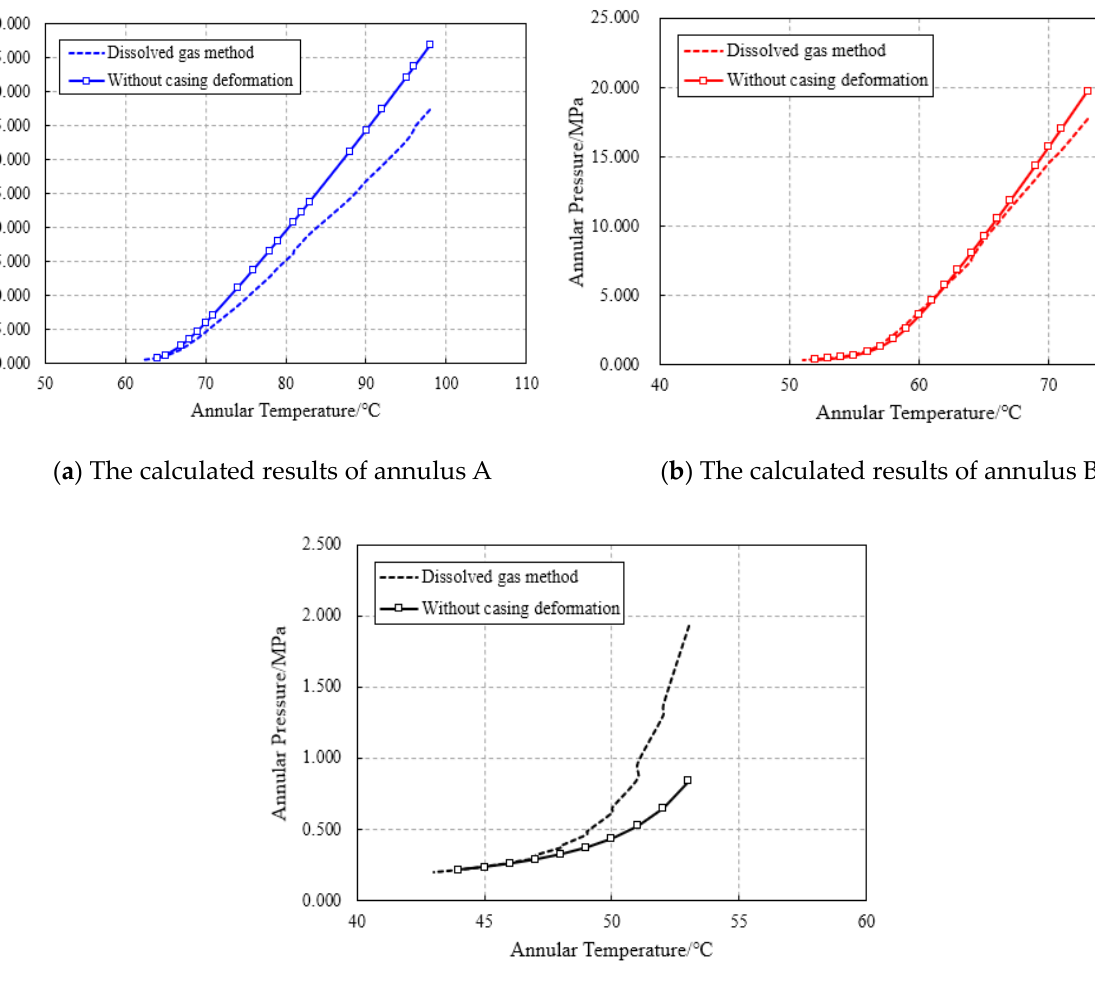
6.600 RMSE: root mean square error. According to the simulations, the pressure value from which the pressure–temperature curve slope becomes stable is associated with the dissolved gas volume fraction in each an- nulus. The smaller the dissolved gas volume fraction is, the closer the calculated results are to the full-liquid model. When dissolved gas volume fraction is less than 0.1%, the predic- tion RMSE and final prediction error are both less than 2 MPa, which is acceptable for prac- tical applications. The two curves are close to each other, which makes the small bend nearly unnoticeable. As a consequence, for all practical purposes, the full-liquid model could be used for convenience when the dissolved gas volume fraction is less than 0.1%.